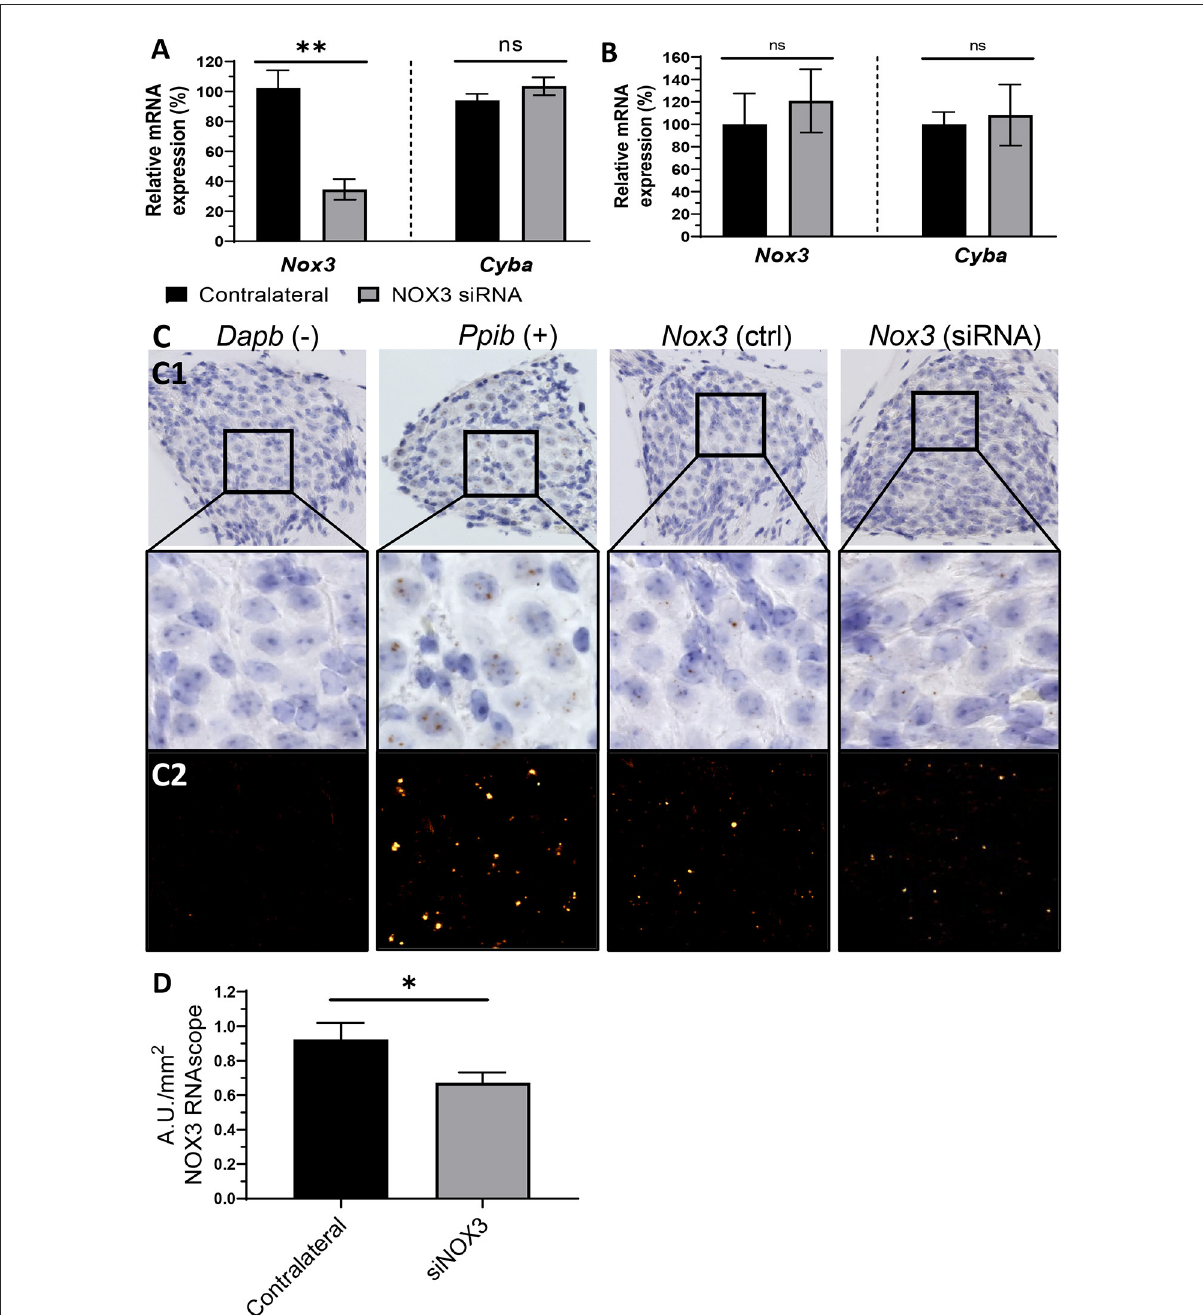
FIGURE7 Silencing of NOX3 in vivo . NOX3 siRNA #248 was manually delivered to the inner ear through the posterior semicircular canal or into the middle ear through the tympanic bulla. (A) Bar graph showing the mRNA level (qPCR) of Nox3 and p22 phox ( Cyba ) 3 days following inner ear delivery (canalostomy) ( n = 6). (B) Bar graph showing the mRNA level (qPCR) of Nox3 and p22 phox ( Cyba ) 3 days following middle ear delivery ( n = 2). (A,B) mRNA level in the siRNA delivered cochlea was normalized to the contralateral cochlea (100%). The data represent the average + - SEM. (C) Representative images corresponding to the Rosenthal’s canal in situ hybridization (BROWN assay) and hematoxylin counterstaining (C1). Dapb (dihydrodipicolinate reductase) probe was employed as negative control (–), while Ppib (Peptidyl-Prolyl Cis-Trans Isomerase was employed as positive control ( + ). DAB channel, corresponding to the mRNA signal, was processed in a fluorescent like manner (LUT applied), in order to facilitate visualization (C2). (D) Bar graph representing RNAscope ( in situ hybridization) Nox3 mRNA signal quantification in the Rosenthal’s canal area. Nox3 signal was normalized to the Rosenthal’s area (mm 2 ). The data represents the average + - SEM of Nox3 signal quantified from five to eight cochlear slices / cochlea from three